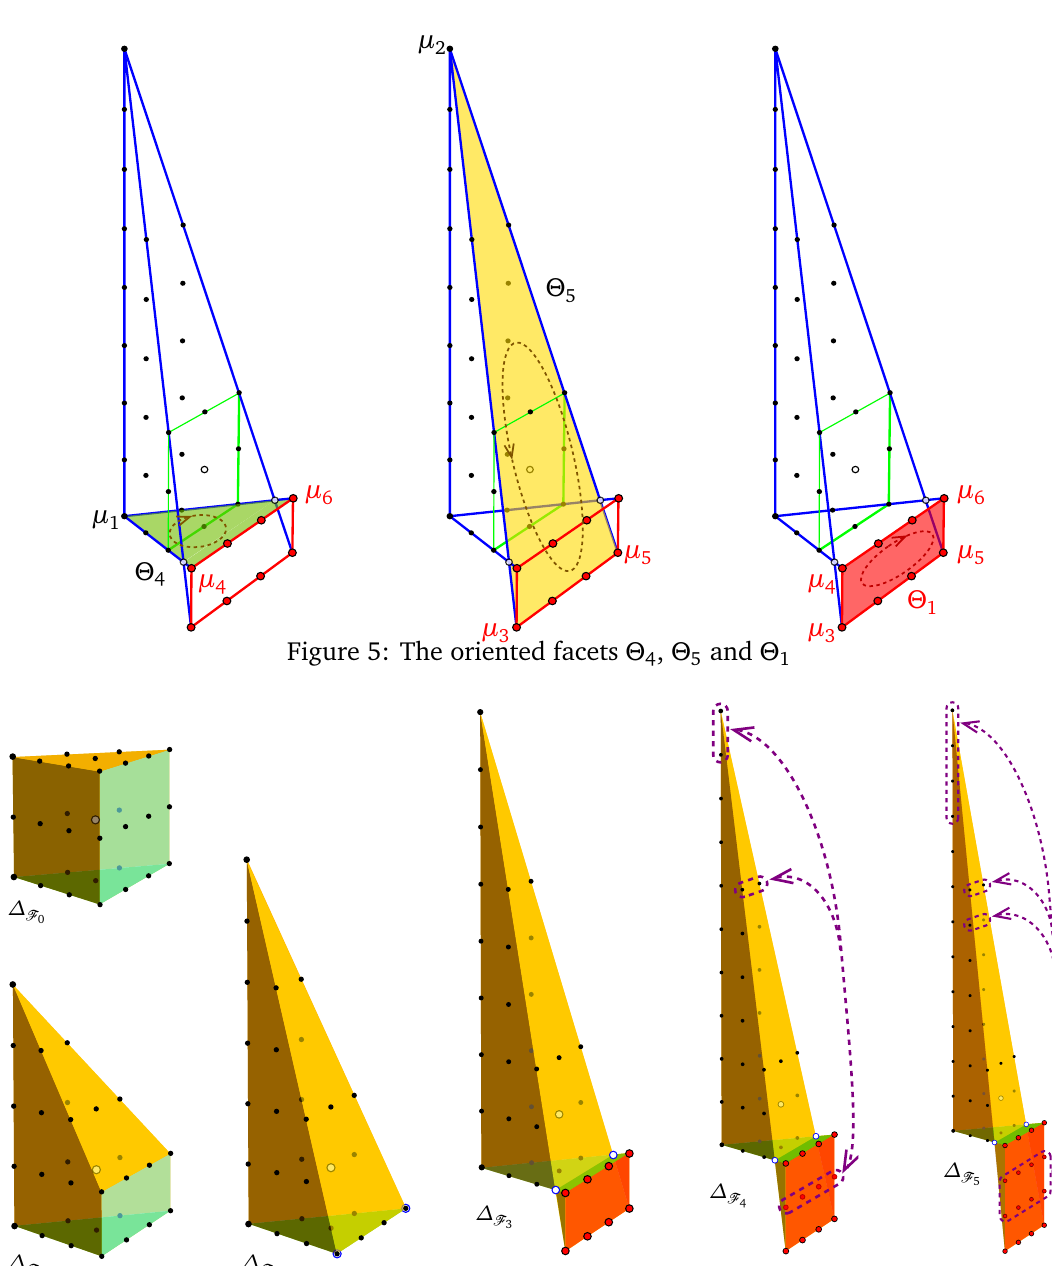
Figure 6: The complete Newton polytopes of the first six Hirzebruch 3-folds; see